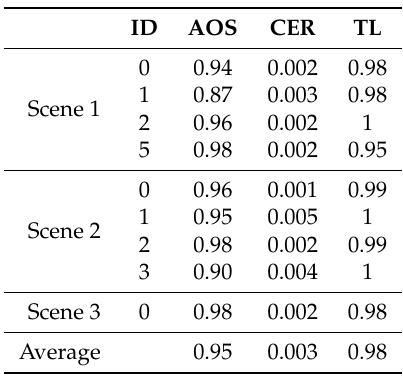
Table 3. Results of the deep learning-based tracking system applied to all three evaluation scenes. For each scene, the resulting measures according to Equations (2)–(4) are given. Tracking IDs are assigned randomly to each particular track. The last row highlights the performance of this system averaged over all